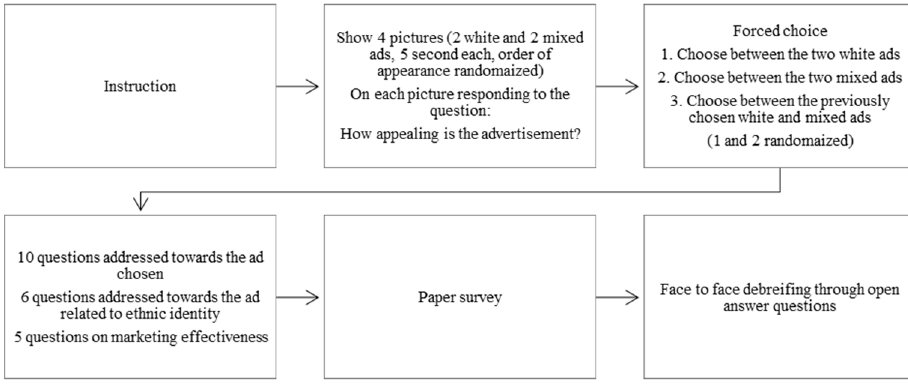
Figure 2. Data collection procedure.